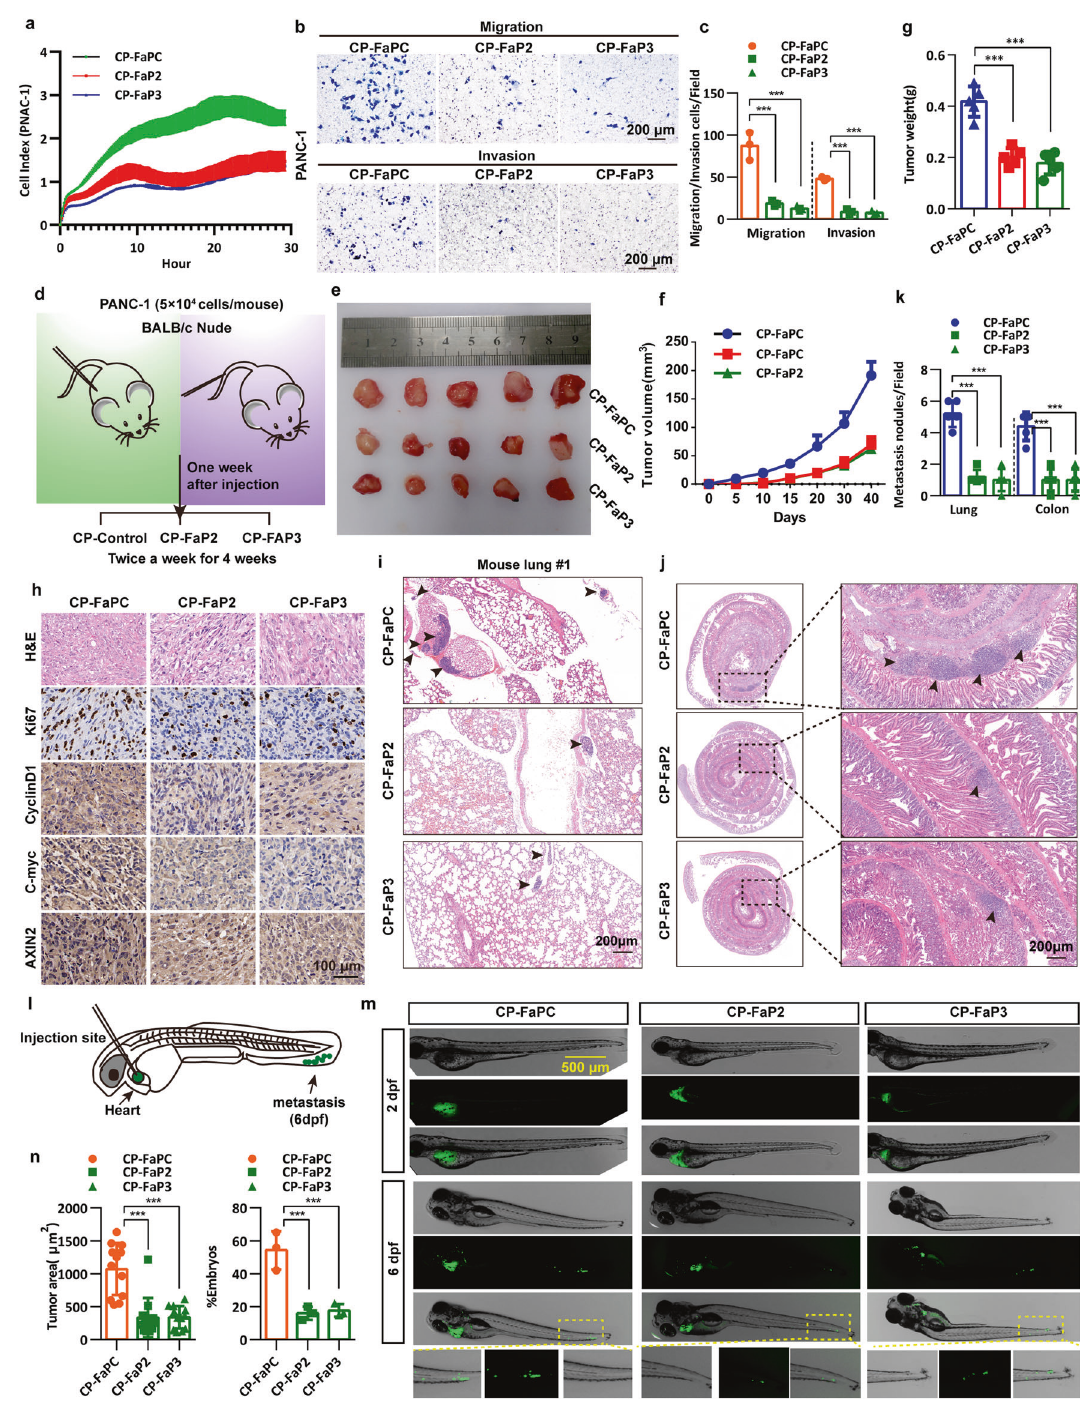
Fig. 9 FAM83A- β -catenin interaction inhibitory peptides restrain pancreatic cancer development. a Real-time cell analysis (cell index, CI) showing the differences in growth pro fi le for PANC-1 cells treated with control (CP-FaPC, 2 mg/kg/2d), CP-FaP2 (2 mg/kg/2d), and CP-FaP3 (2 mg/kg/2d) peptides measured in a 16-well E-plate. b , c Representative images and quanti fi cation of the transwell assays with or without matrigel of PANC-1 cells treated with control, CP-FaP2, and CP-FaP3 peptides ( n = 3). d Schematic diagram of the experimental procedure of the treatment of the peptides to nude mice xenograft formation and tail vein injection. e Representative images of excised tumors in the groups with respective peptides treatment were shown. f The growth curve shows the changes in the tumor volume in mice in different groups ( n = 5). g Weight of the excised tumors in each group ( n = 5). h Representative H&E staining images and immunohistochemical images of Ki67, C-myc CyclinD1, and AXIN2 expression in excised tumors tissues. i – k Representative images and quanti fi cation of lung and colon metastasis of each group was shown ( n = 5). l Schematic diagram of the zebra fi sh embryo xenograft assay. m Representative overview images at two days and six days post-implantation of zebra fi sh injected with EGFP-tagged PANC-1 cells. Scale bar: 500 μ m. n Quanti fi cation of the area of metastatic cells in individual zebra fi sh embryos ( n = 15) and the percentage of the zebra fi sh embryos displaying tumor progression to the tail fi n ( n = 3)